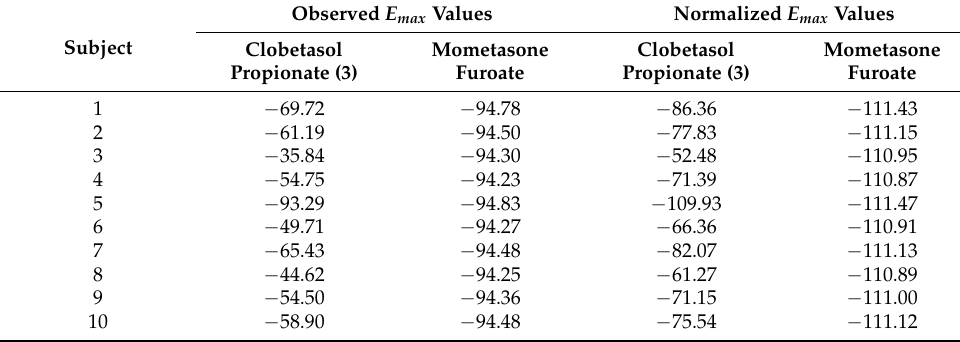
Table 4. Individual subject results from Study